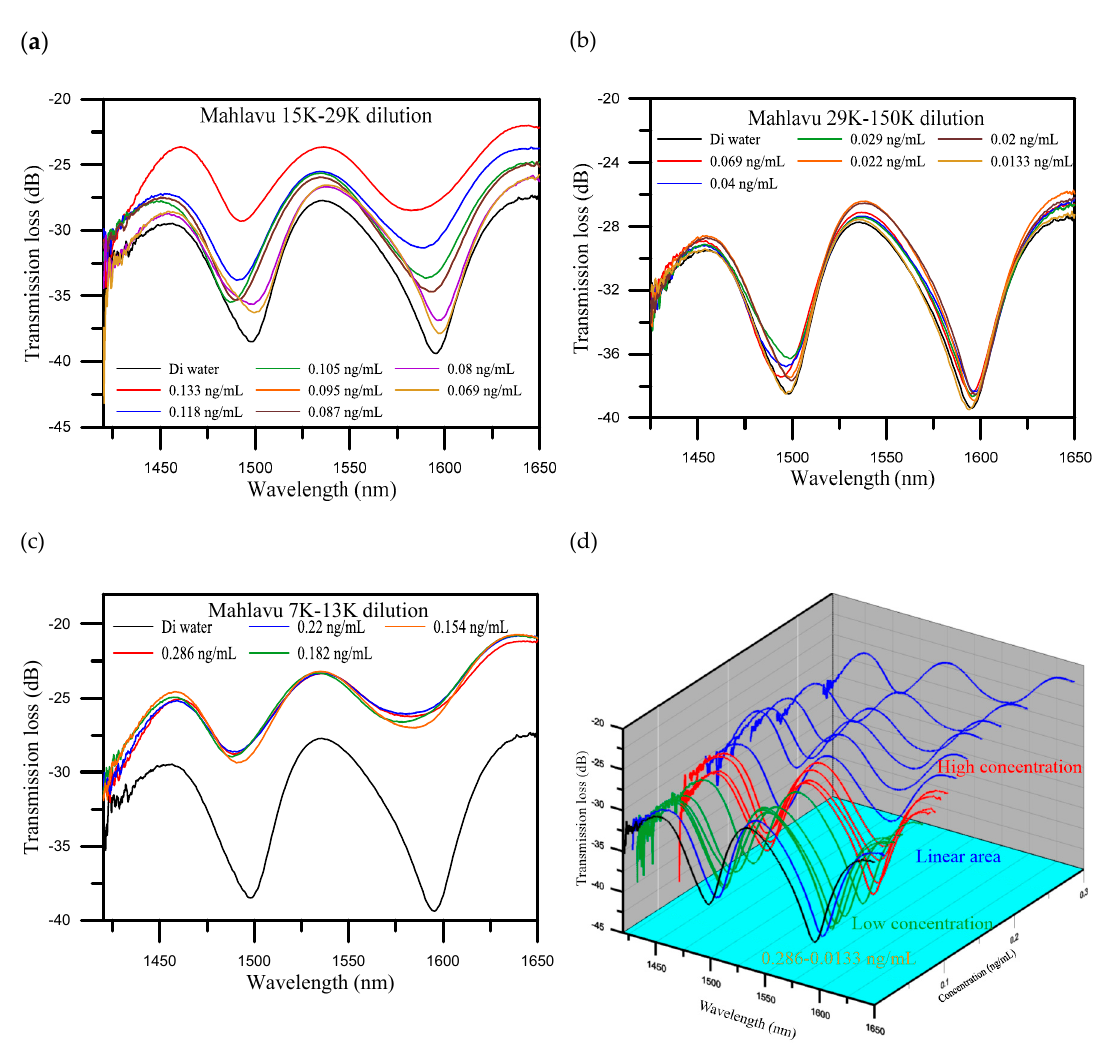
Figure 4. Spectrum diagrams of different concentrations of Mahlavu specimen solutions which were divided into three areas. ( a ) The high concentration area; ( b ) the linear area; ( c ) the low concentration area; and ( d ) three-dimensional (3D) spectrum diagrams of all concentrations.